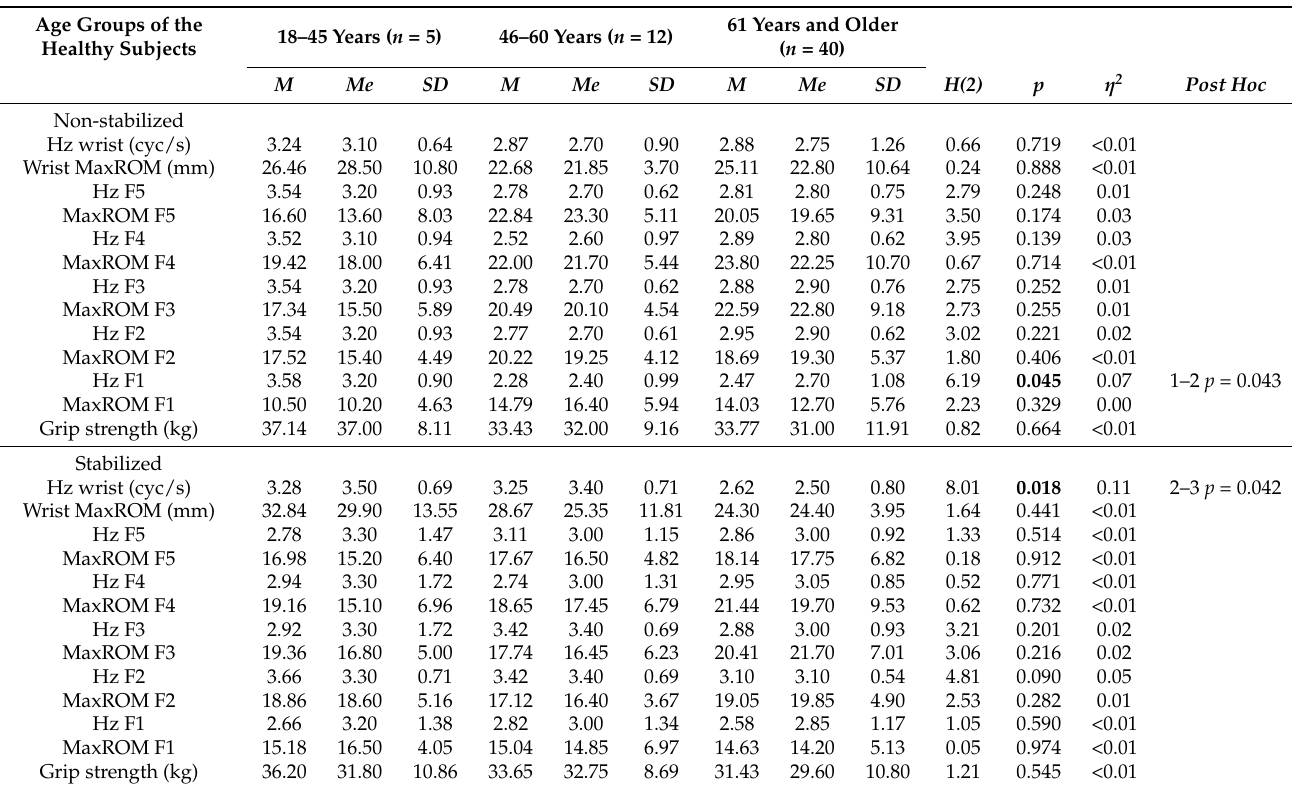
Table 7. Comparison of age groups of the healthy subjects, in terms of the parameters measured in the unstable and stable.